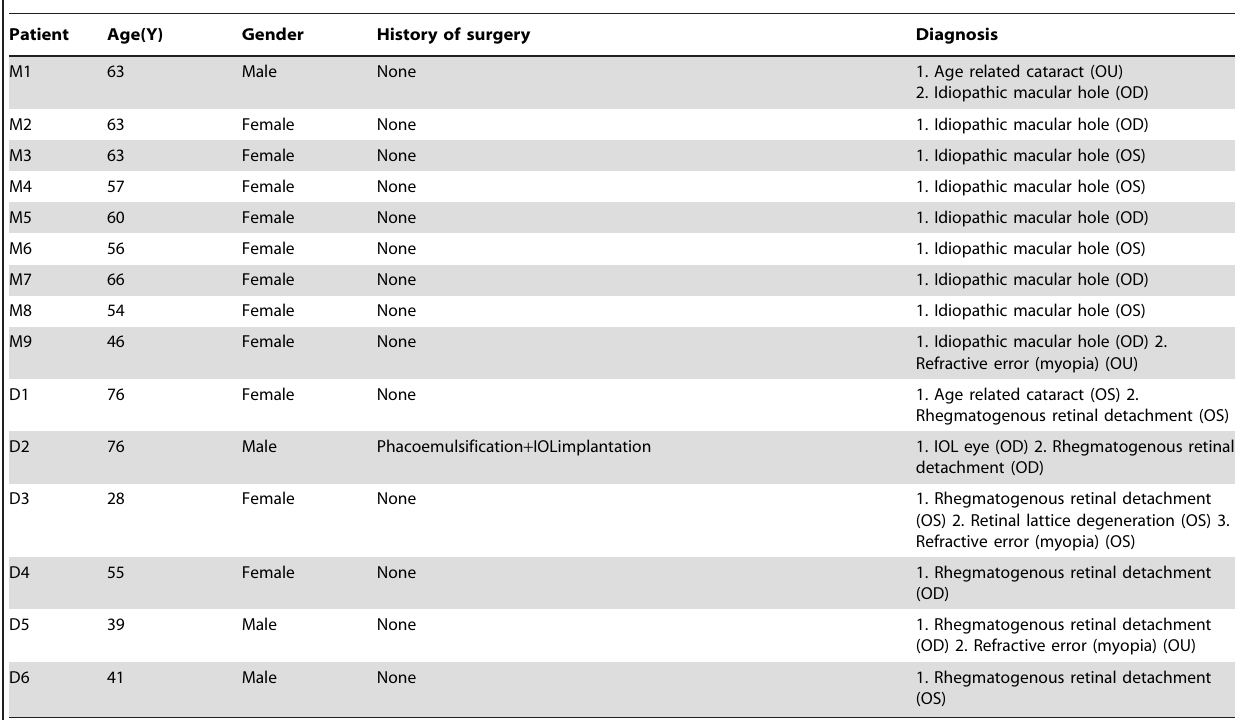
Table 2. Demographic and ocular Characteristics of patients in control